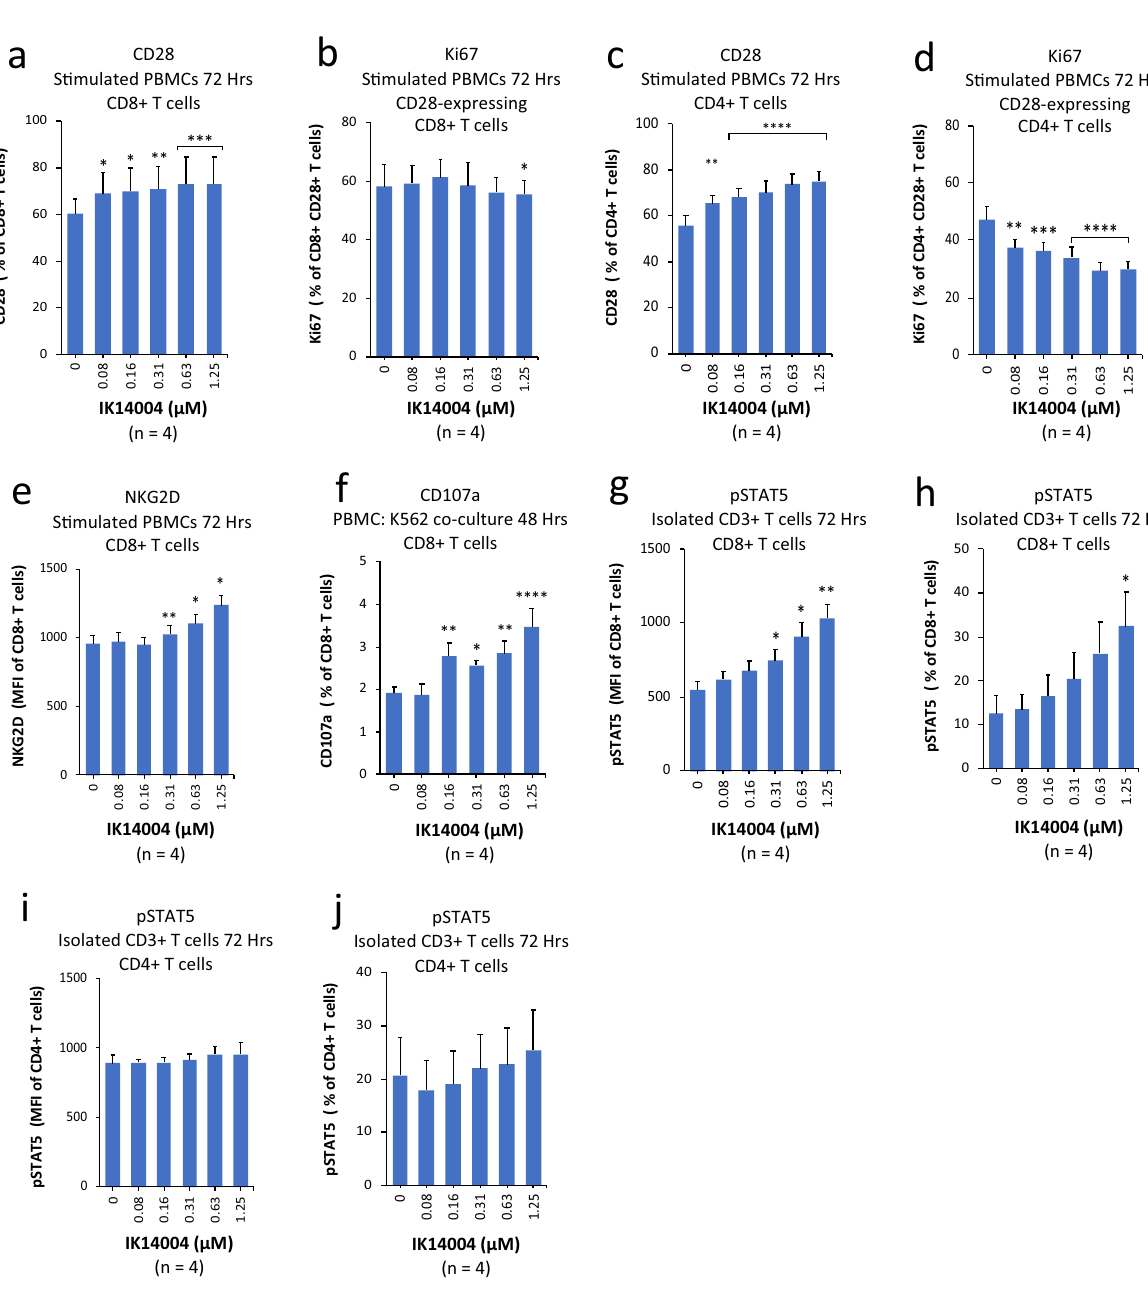
Figure 3. IK14004 enhances expression of activating co-receptors in CD8+ T cells and induces STAT5 activation. Experiments with PBMCs or isolated CD3+ T cells were performed using triplicate wells (technical replicates) for each experiment and flow cytometry experiments were repeated four times (n = experimental replicates) as indicated below each panel. All error bars represent standard error of the mean (SEM). Cells were cultured for 48 h in a granzyme B assay (CD107a) and in all other experiments for 72 h. The granzyme B assay is described in the “Methods”. The compound shown is IK14004 as indicated under each panel. Flow cytometry data are shown as percentages and mean fluorescence intensity (MFI). Dot plots and gating strategies are shown in Supplementary Figs. S18 to S27. ( a ) Percentage of CD28 + CD8 + T cells within PBMC cultures. ( b ) Percentage of Ki67 + CD28 + CD8 + T cells within PBMC cultures. ( c ) Percentage of CD28 + CD4 + T cells within PBMC cultures. ( d ) Percentage of Ki67 + CD28 + CD4 + T cells within PBMC cultures. ( e ) Expression of NKG2D in CD8 + T cells within PBMC cultures. ( f ) Percentage of CD107a + CD8 + T cells within a PBMC : K562 co-culture assay. ( g ) Expression of pSTAT5 in CD8+ T cells within T cell cultures. ( h ) Percentage of pSTAT5- expressing CD8+ T cells within T cell cultures. ( i ) Expression of pSTAT5 in CD4+ T cells within T cell cultures. ( j ) Percentage of pSTAT5-expressing CD4+ T cells within T cell cultures. Data were analysed using repeated measures (RM) two-way ANOVA with Dunnett’s post-test comparing peptide with vehicle control. *P < 0.05, **P < 0.01, ***P < 0.001, ****P <